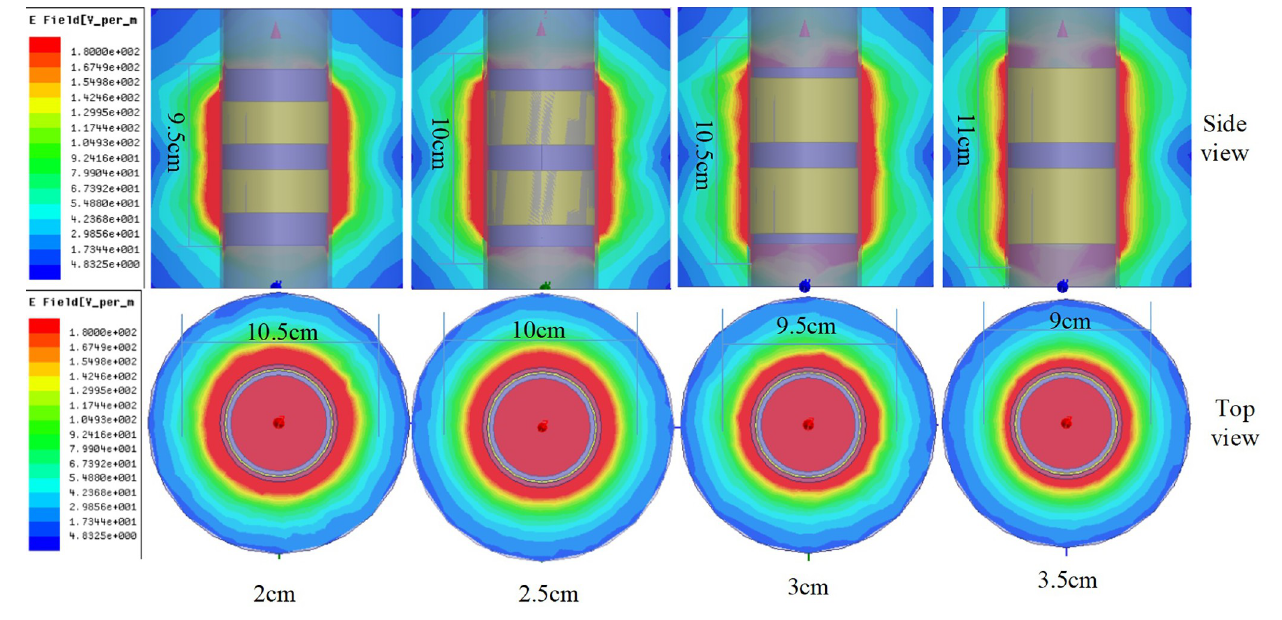
Fig 7. Simulation of electrical field distribution of a ring probe.